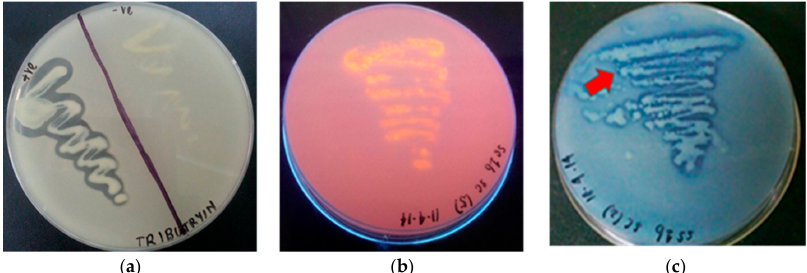
Figure 1. ( a ) Lipolytic activity clearing zone on tributyrin agar; ( b ) lipolytic activity on Rhodamine B, with substrate hydrolysis leading to the formation of an orange fluorescent halo upon exposure to UV radiation; and ( c ) lipolytic activity confirmation due to change in ( ) colour of dye indicators on triolein